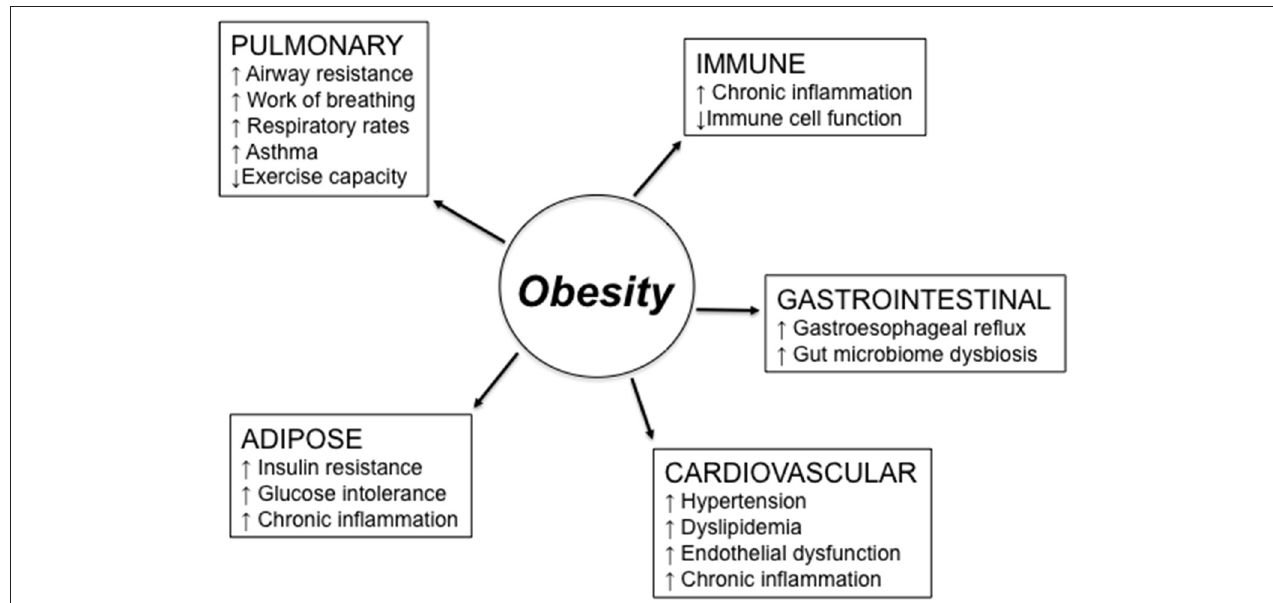
FIGURE 1 | Obesity effects on different body systems involved in the response to respiratory tract infections. Obesity-induced changes in the lung may be due to higher weight load on the thorax and lead to reduced lung function. Obesity-induced changes in the immune system lead to chronic inflammation, immune activation, and reduced clearance of pathogens. Obesity also causes gastroesophageal reflux, which is a risk factor for aspiration pneumonia and asthma, due to the excess of belly fat posing pressure on the stomach, and gut microbiome dysbiosis. Cardiovascular complications of obesity include hypertension, dyslipidemia, and endothelial dysfunction. Obesity-induced changes in the adipose tissue are responsible for increased insulin resistance and glucose intolerance, both leading to chronic